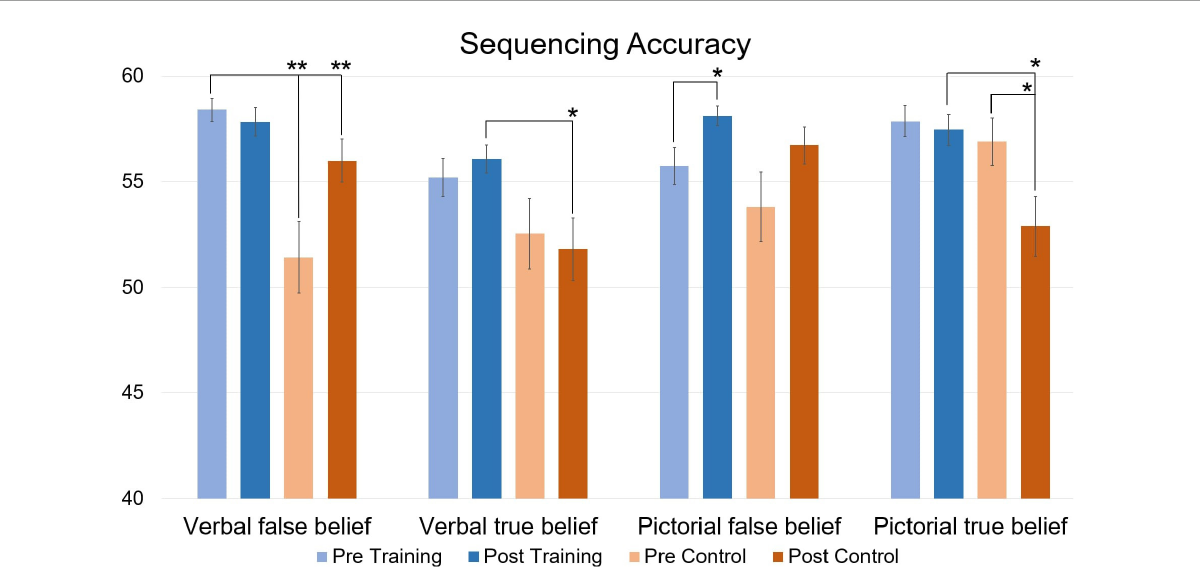
FIGURE4 Accuracy of verbal and pictorial true- and false-belief sequencing comparing pre and post scores in function of Training and Control groups, expressed in mean total accuracy scores per condition (maximum score is 60). Error bars represent the Standard Error of Means (SEM). * p < 0.05, ** p < 0.001 F -test between pre- and post-measurement and between groups.